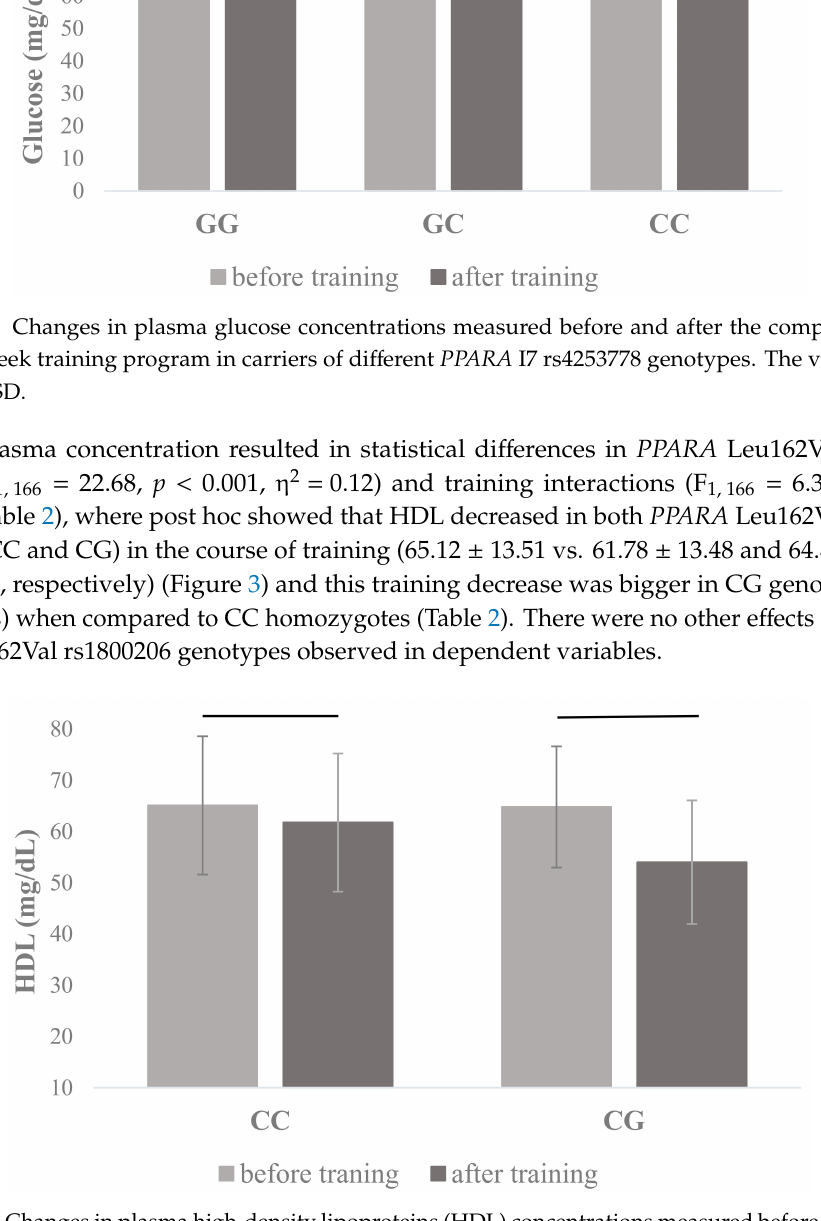
Figure 3. Changes in plasma high-density lipoproteins (HDL) concentrations measured before and after the completion of the 12-week training program in carriers of di ff erent PPARA Leu162Val rs1800206 genotypes. The values are mean ±